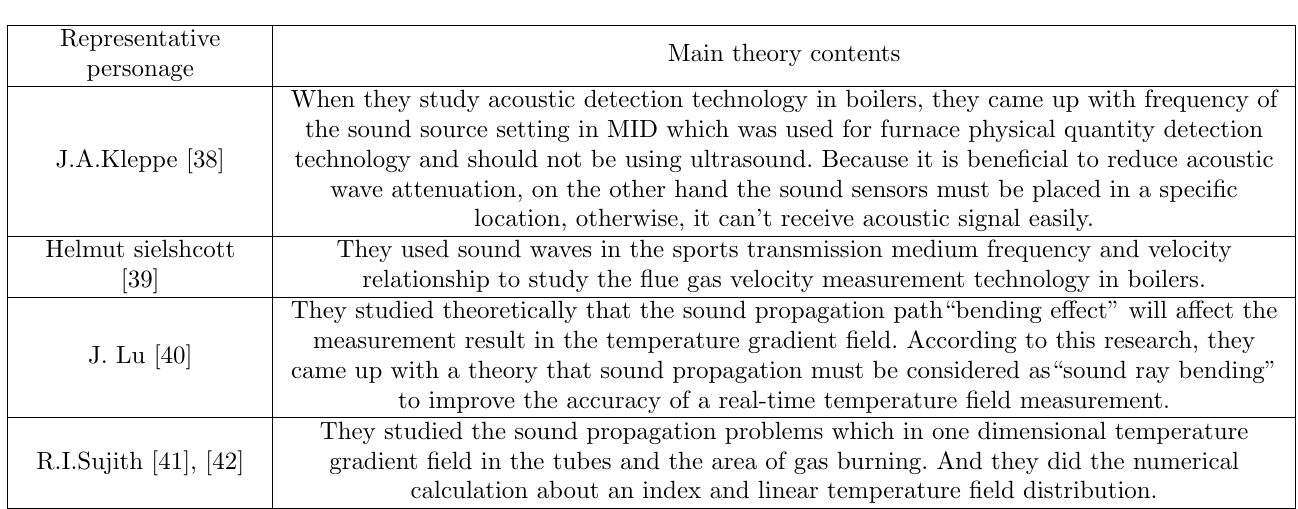
Table 4. The research and development situation of the theory of tube leak detection technology for the heat exchanger in boilers